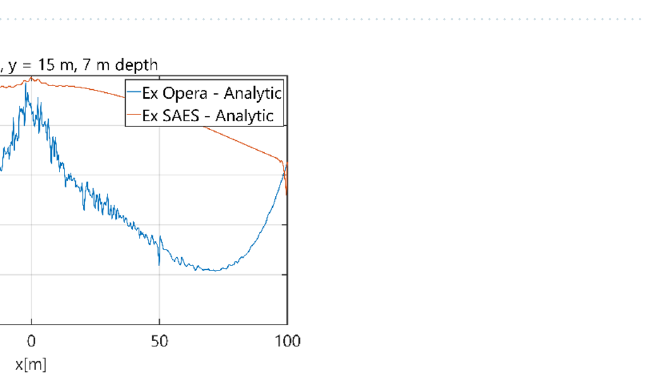
Figure 15. Distribution of differences between E x values obtained from Opera (FEM) and SAES (BEM) models and the analytical model ( y = 0 m, z = − 7 m).